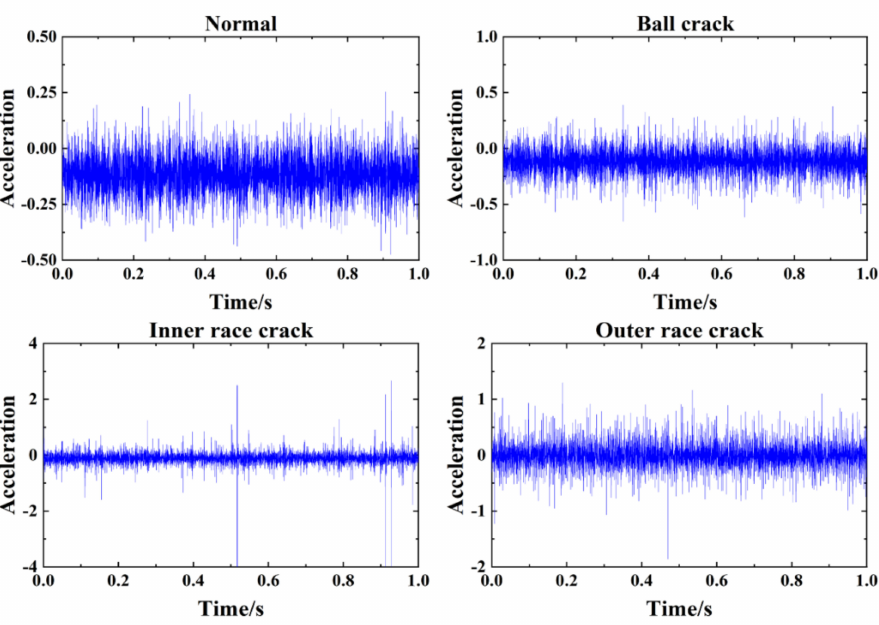
Figure 5. Wavelet de-noising time domain waveform of IMS bearing test raw data.